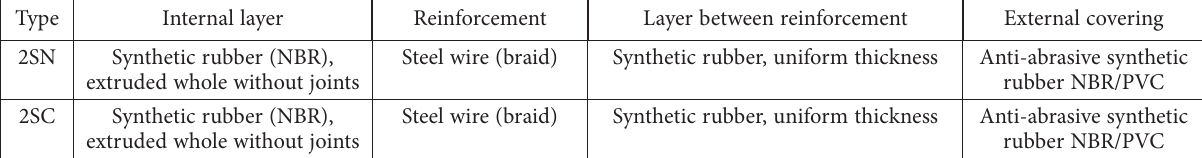
Table 2. High-pressure hoses layers